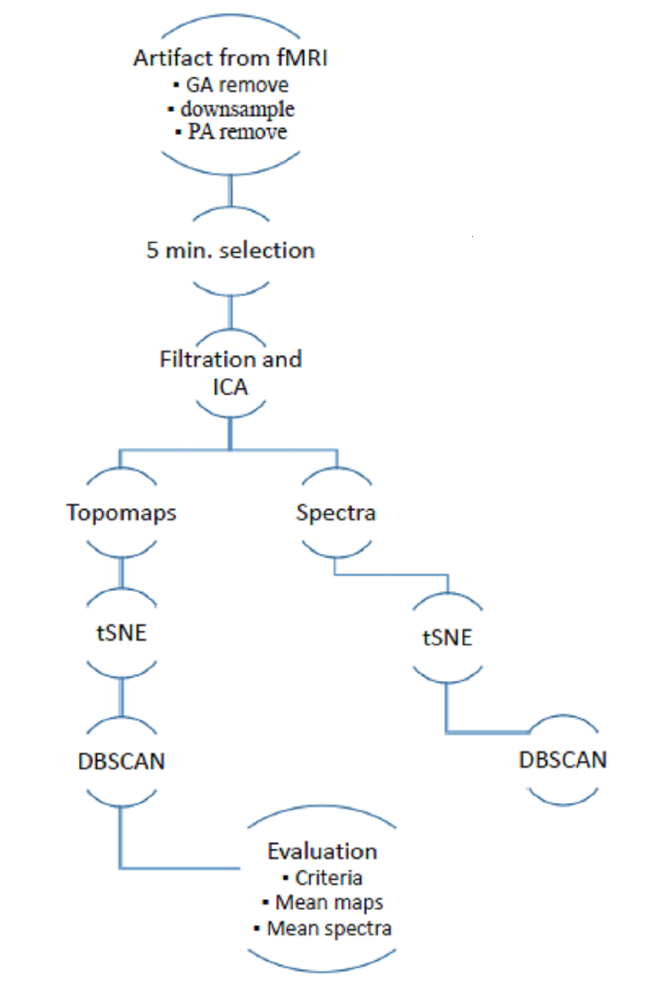
Figure 1. Schema of semiautomatic extraction of artifacts from simultaneously recorded electroencephalogram (EEG) in functional magentic resonance imagin